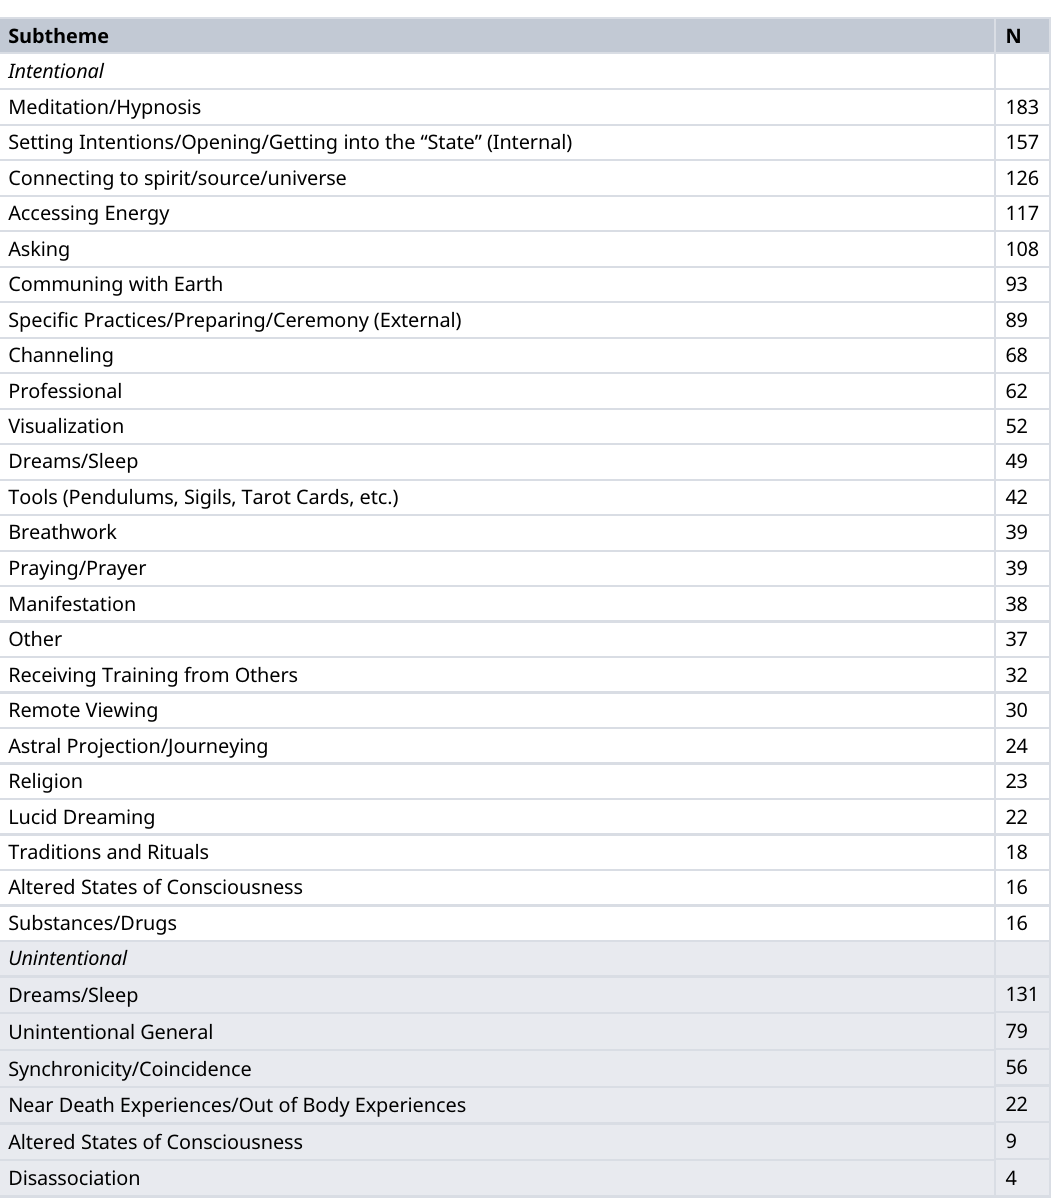
Table 2. Theme 1 Ways of engagement subthemes and counts. Subtheme N